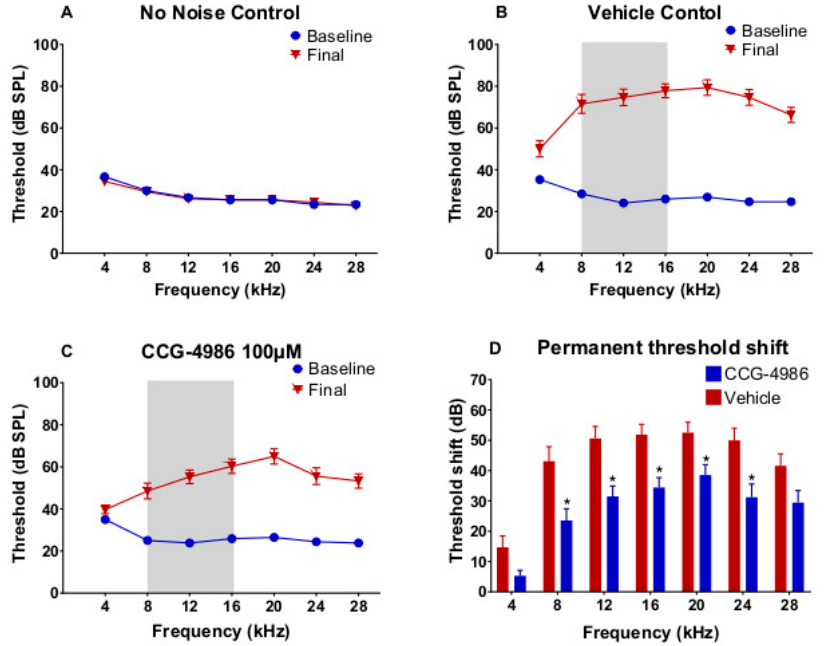
Figure 2. Baseline and final auditory brainstem responses (ABR) thresholds for 4–28 kHz tone pips in animals exposed to octave band noise (8–16 kHz, 110 dB SPL) for 2 h and non-exposed animals. Grey area denotes noise band. ( A ) Controls exposed to ambient noise (55–65 dB SPL) in the animal facility. ( B ) Noise-exposed vehicle-treated control group. ( C ) Animals treated with CCG-4986 (100 µ M) 48 h post-exposure. ( D ) Comparison of permanent threshold shifts 16 days post-exposure in drug- and vehicle-treated animals. Data presented as mean ± SEM. No noise control, n = 10; Vehicle control, n = 16; CCG-4986, n = 17. * p < 0.05; Two-way ANOVA followed by Holm–Sidak post-hoc